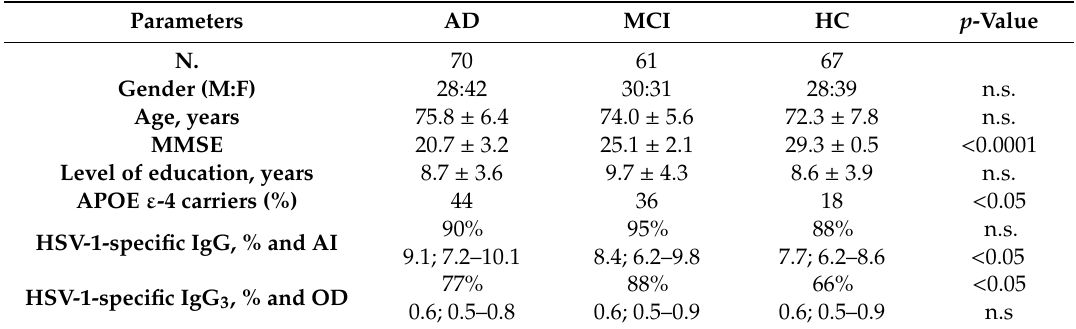
Table 1. Demographic, clinical and virological characteristics of subjects enrolled in the